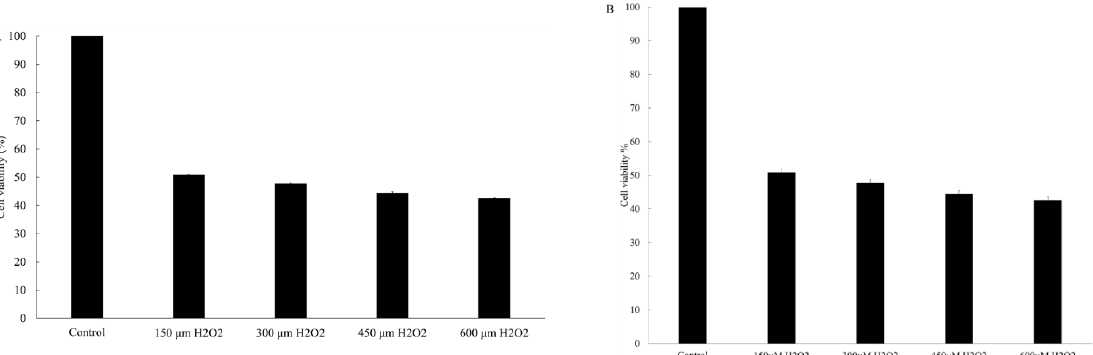
Figure 1. Effect of various concentrations of tetrahydrocurcumin (THC) ( A ) and H 2 O 2 ( B ) on the viability of HaCaT cells after 24 h of treatment.